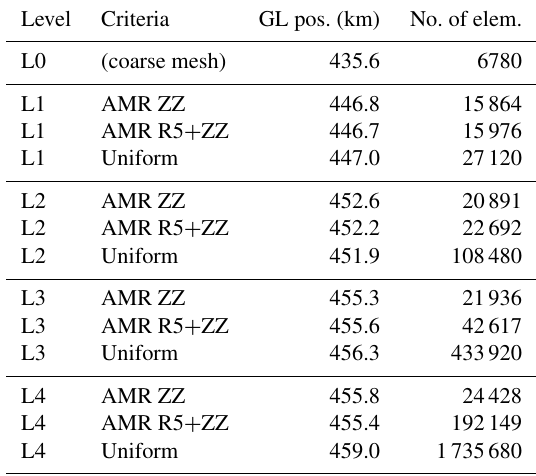
Table 4. AMR criteria comparison for the MISMIP +